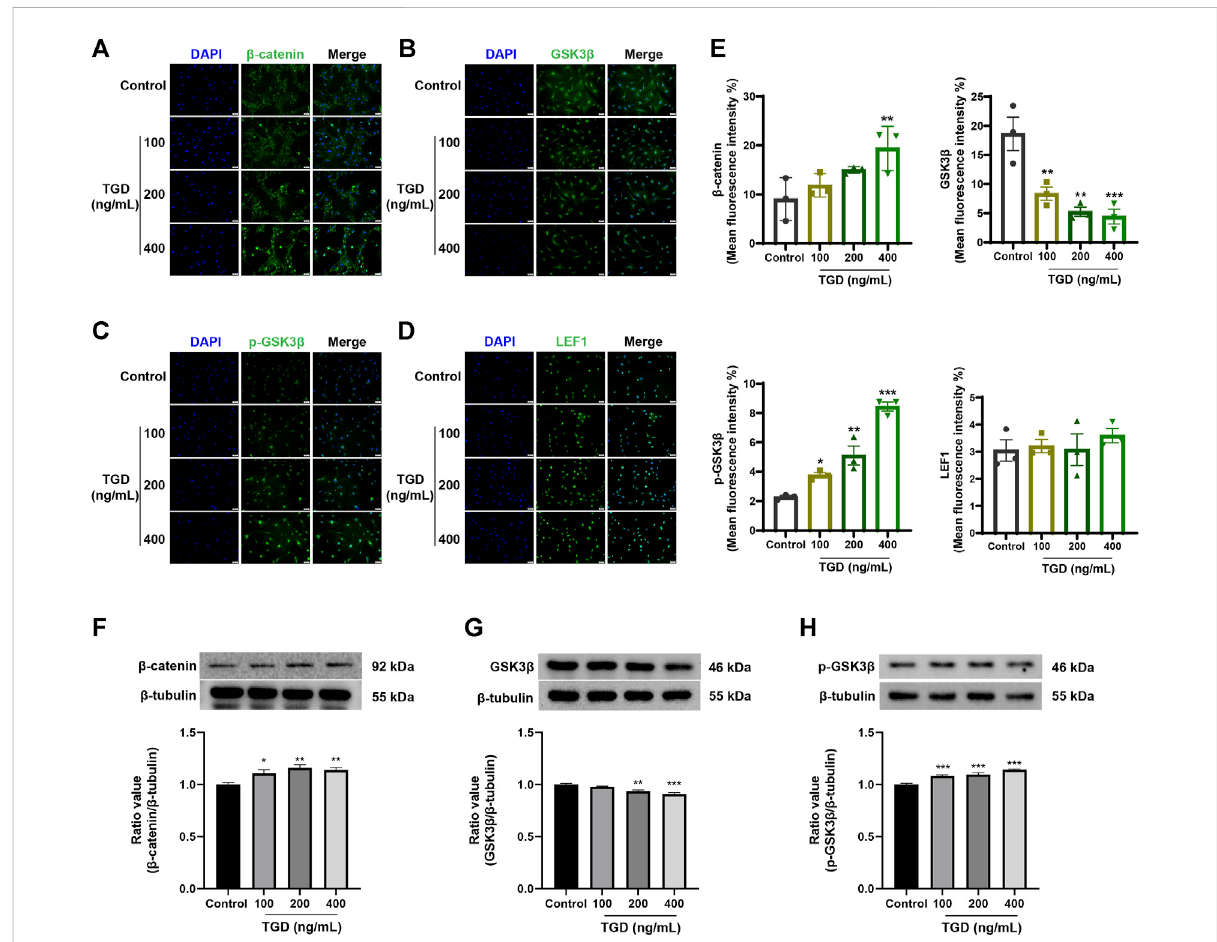
FIGURE 9 (A – E) The representative images and statistical graph of β -catenin, GSK3 β , p-GSK3 β and LEF1 in DPCs (×200), n = 3 per group, * p < 0.05, ** p < 0.01,and*** p < 0.001vs.thecontrolgroup. (F – H) WesternblotanalysisofWnt/ β -cateninsignalingpathwaysrelatedproteinexpressioninDPCs, n = 4 per group, * p < 0.05, ** p < 0.01, and *** p < 0.001 vs. the control